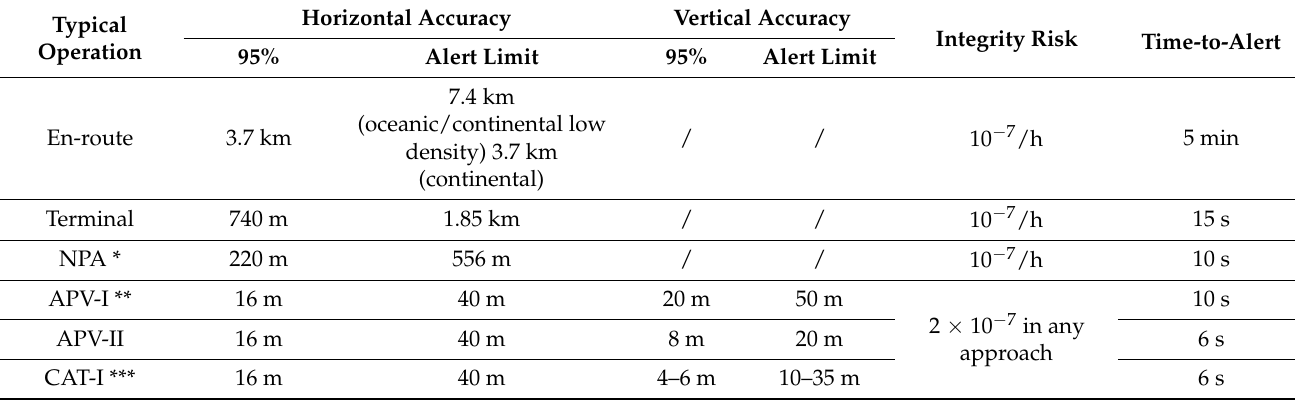
Table 2. ICAO GNSS Signal-in-Space performance requirements (ICAO, 2018 [42]).